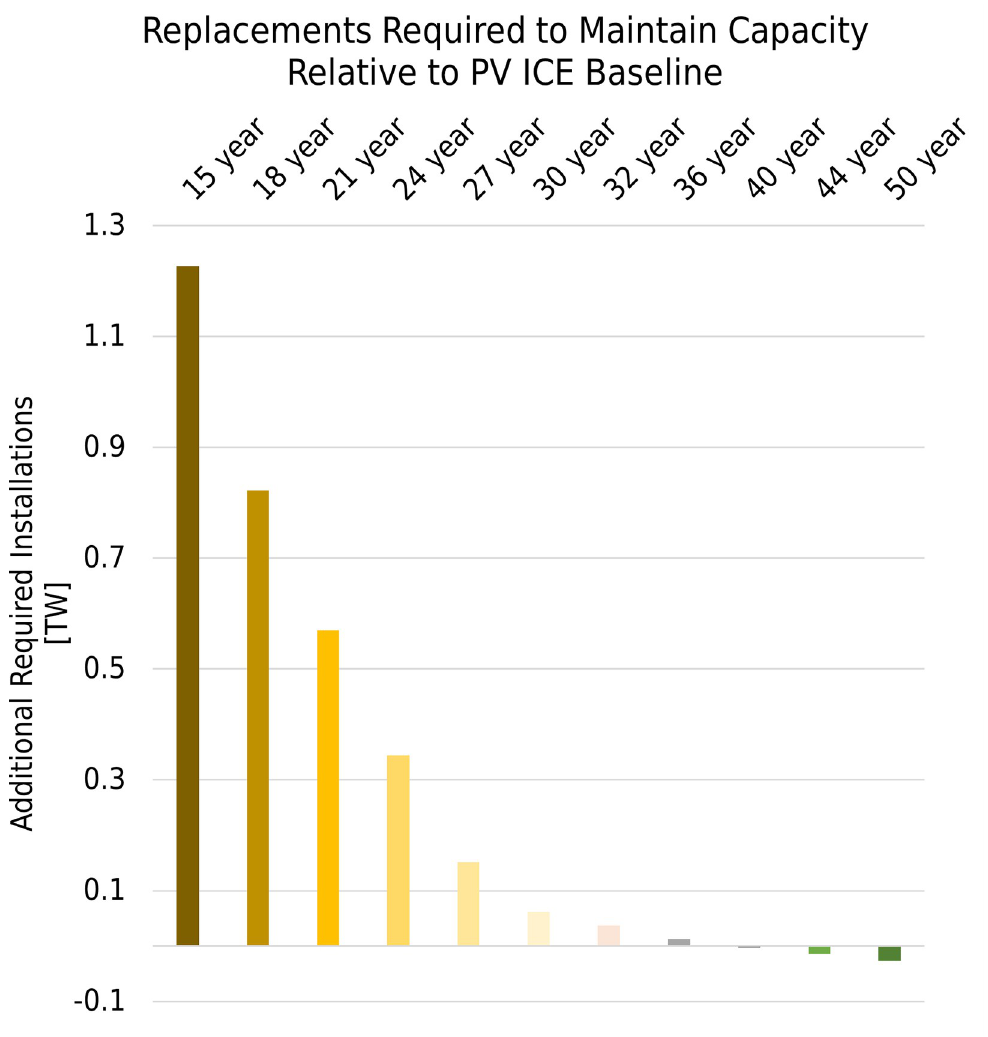
Fig 3. Cumulative required replacements. Cumulative additional nameplate installations required to replace failed modules and maintain effective capacity by module lifetime. The increase or decrease in required installations is relative to the effective capacity for the PV ICE